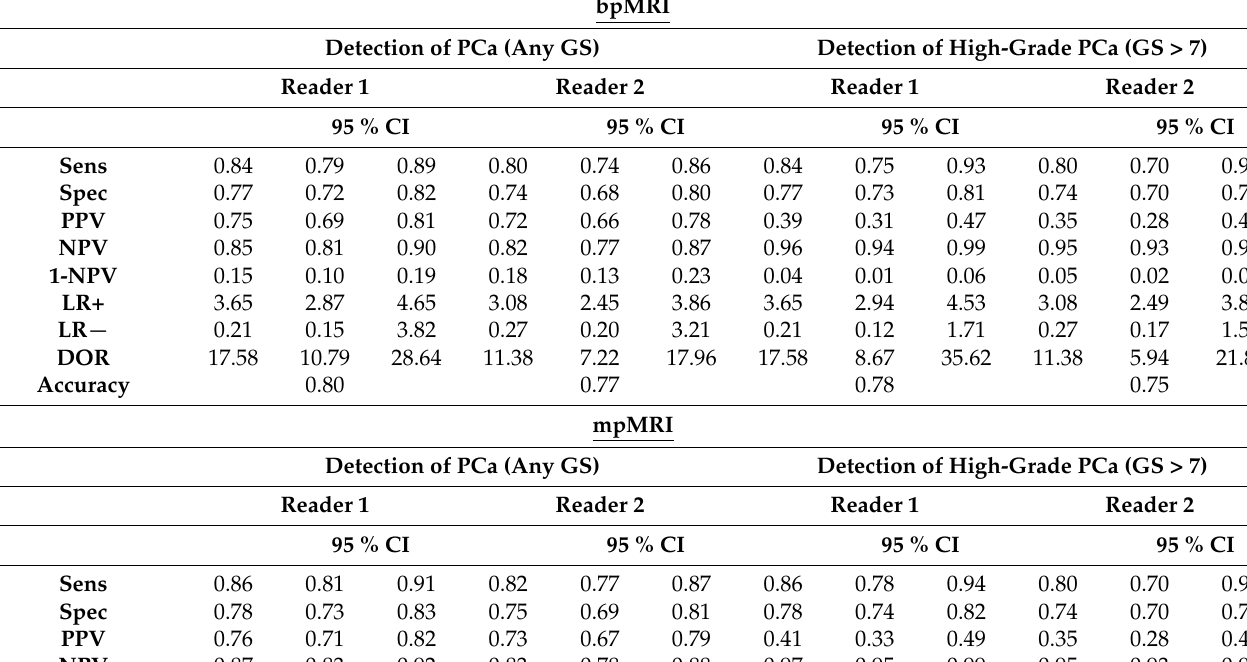
Table 3. Diagnostic performance of each reader for both mpMRI and bpMRI.